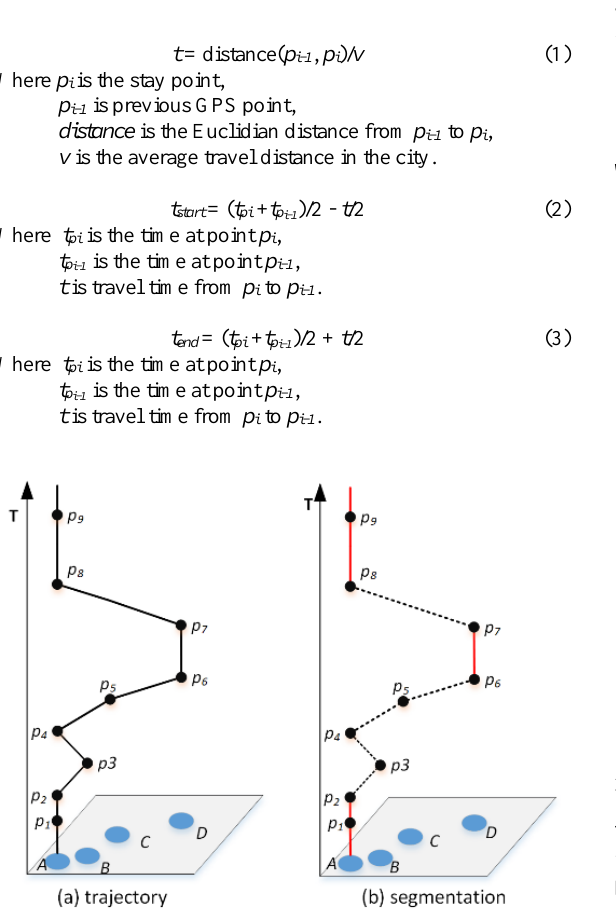
Figure 2. The detection of move and stay